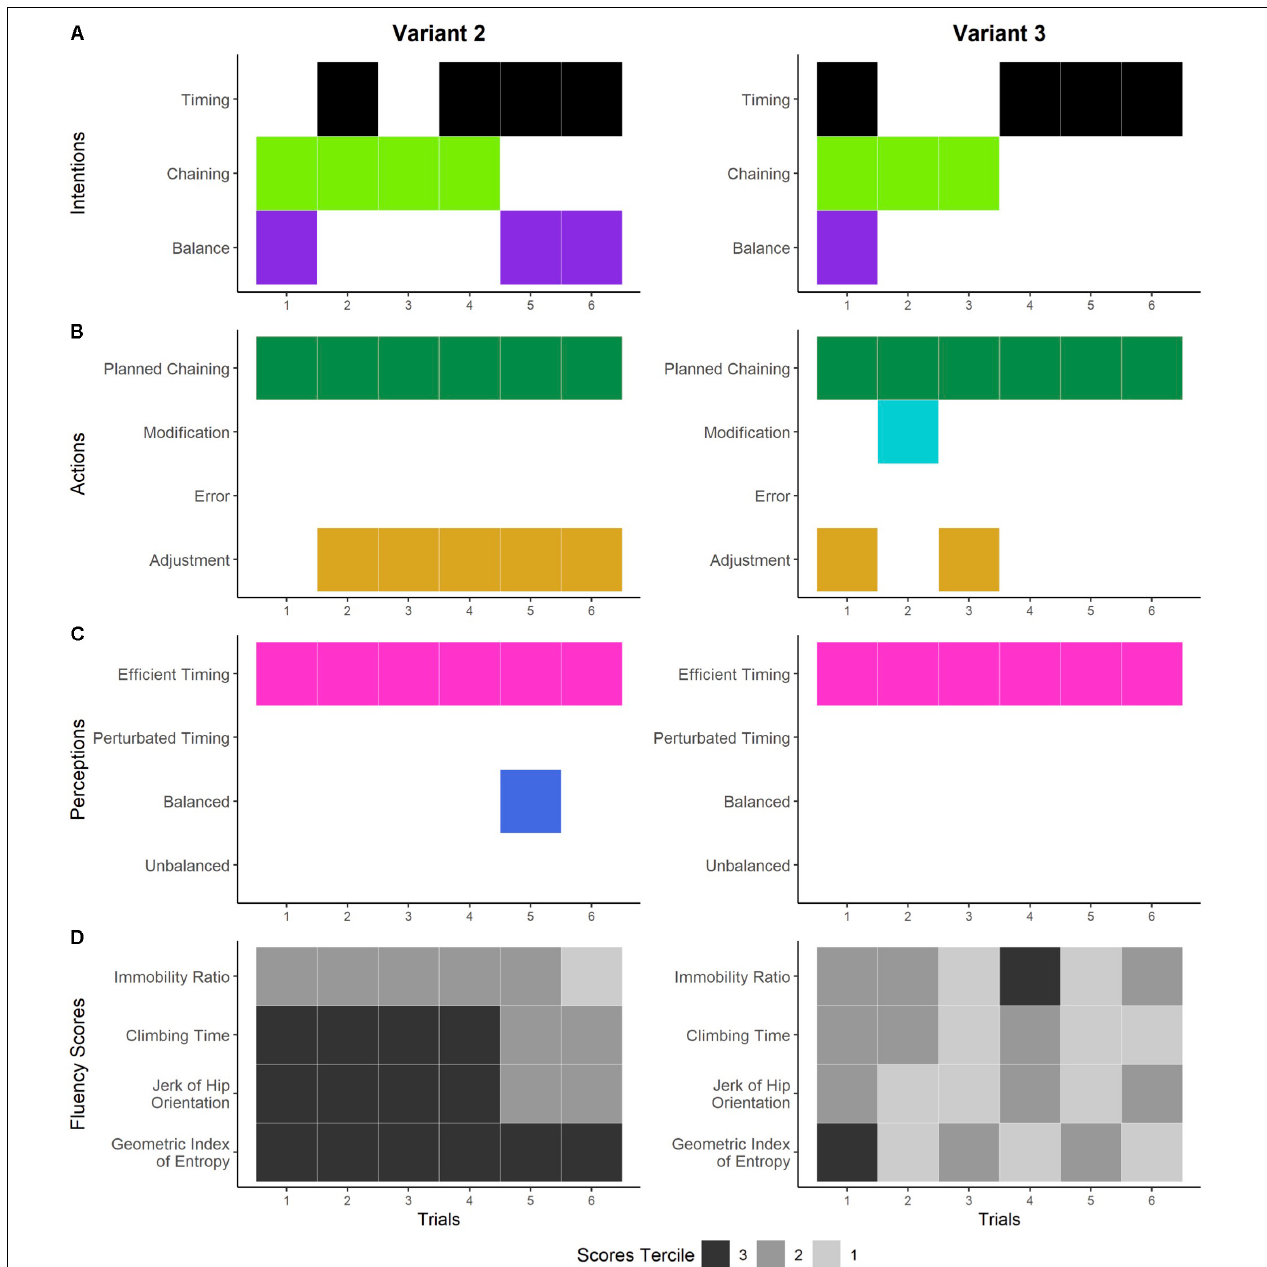
FIGURE 5 | Dynamics of the climber’s experience and performances on variants 2 and 3. Panels A–C show the temporal organization of the general dimensions of the different components of experience detected during the interviews. Panel A shows the general dimensions of the climber’s intentions: improving the timing of the climb (black), ensuring the correct execution of movement chaining (light green), and seeking and maintaining balance while climbing (purple). The climber’s actions are shown in panel B: Carrying out the planned chaining (dark green), deliberately modifying the planned movements while climbing (light blue), making errors while climbing (red), and adjusting the foot chaining while climbing (gold). Panel C shows the general dimensions of the climber’s perceptions: sensation of efficient timing (pink), sensation of perturbed timing (orange), sensation of being balanced (dark blue), and sensation of being unbalanced (green). Panel D shows the score terciles for each fluency indicator. The climbing performance is expressed in the terciles: tercile 3 (in black) refers to his poorest performances, tercile 2 (in dark gray) refers to his intermediate performances, and tercile 1 (in light gray) refers to his best performances.